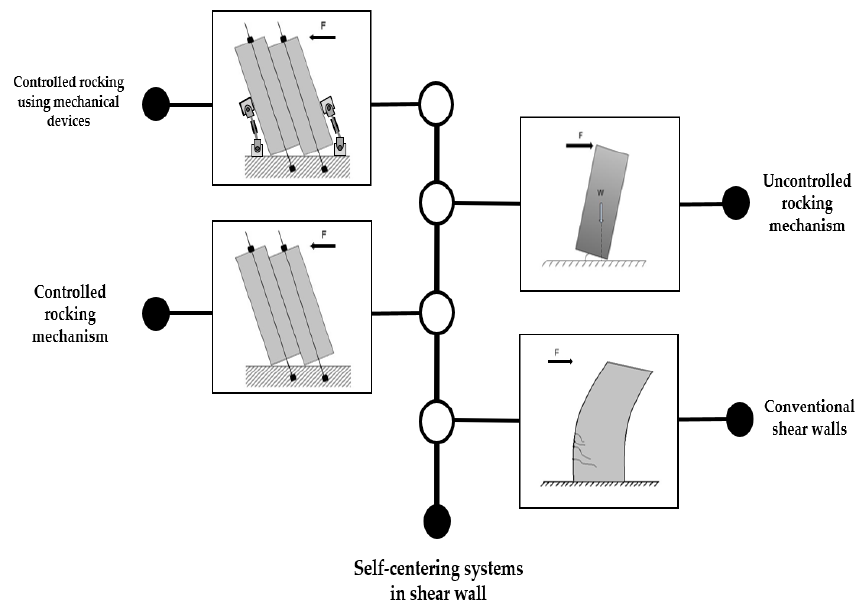
Figure 8. General self-centering systems in shear walls.